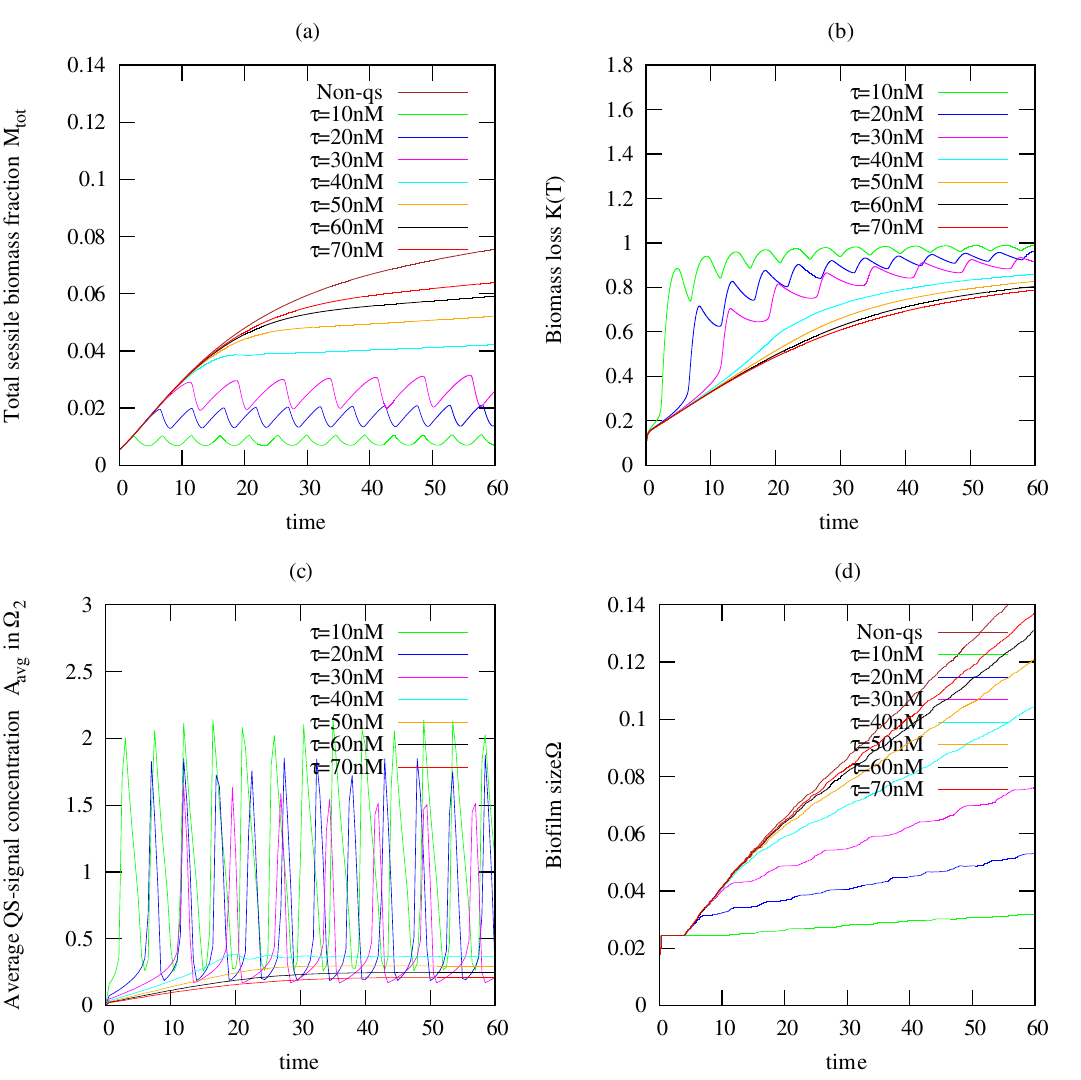
Fig 3. Temporal plots of simulations computed for a non-quorum sensing producing biofilm (Non-QS) and a quorum sensing producing biofilm. Here we used seven different quorum sensing threshold values τ = {10, 20, 30, 40, 50, 60, 70} nM and fixed maximum dispersal rate η 1 = 3.6/ d . Shown are (a) the total sessile biomass fraction M tot in the biofilm, (b) biomass loss K ( T ) indicating the amount of biomass that actually dispersed, (c) the average autoinducer concentration A avg in Ω 2 , and (d) the biofilm size ω ( t